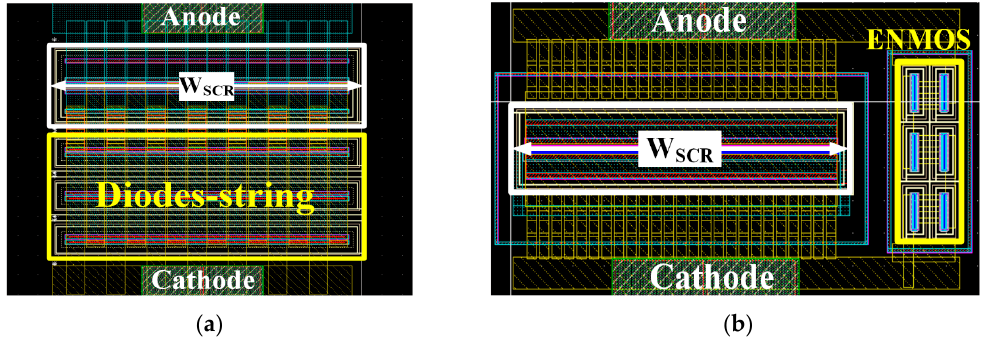
Figure 2. Layouts of ( a ) the conventional DTSCR and ( b ) the proposed MTSCR device.